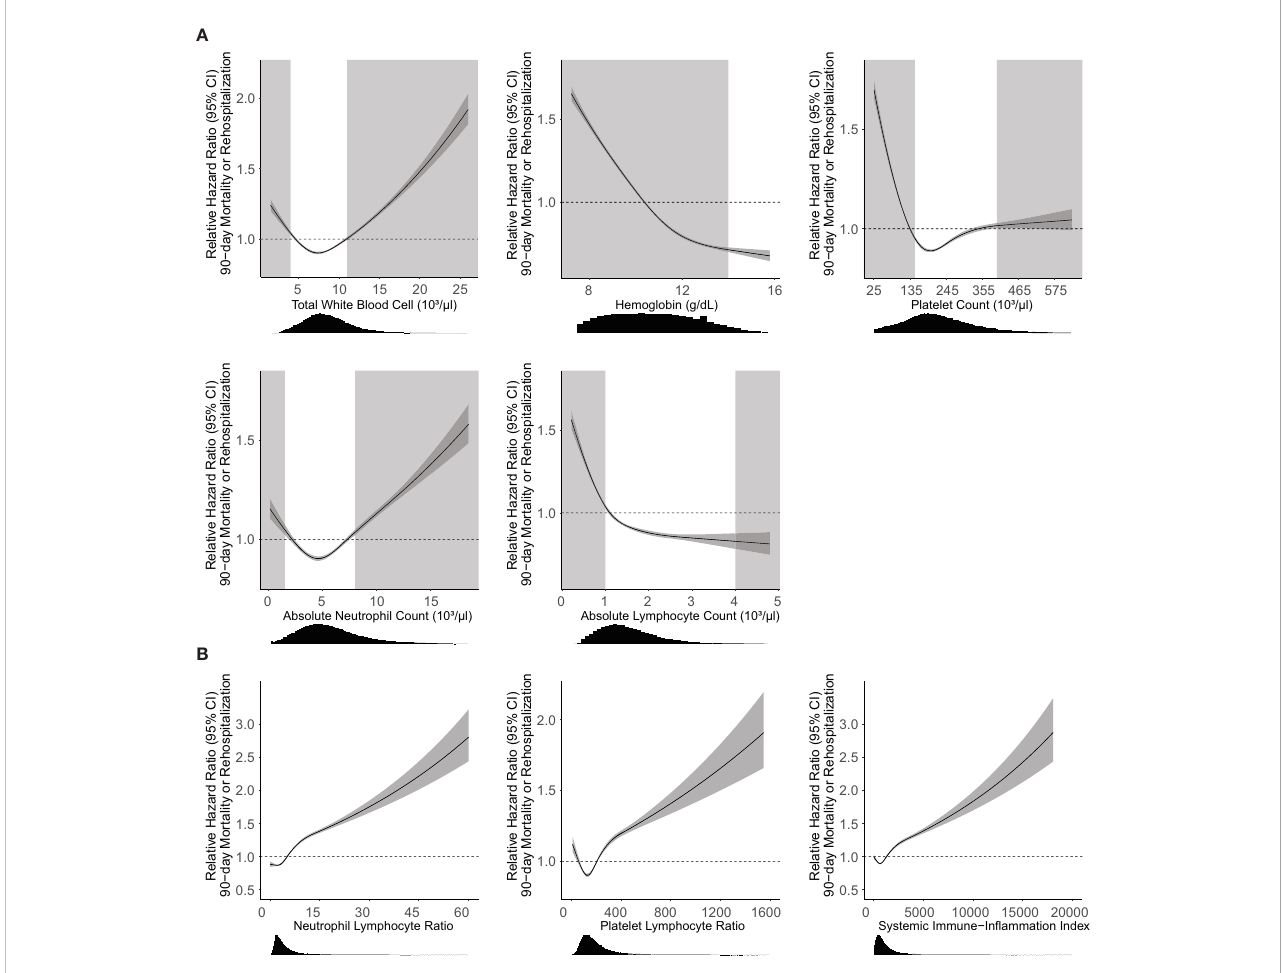
FIGURE 2 Association of CBCD parameters with 90-day mortality or rehospitalization. Unadjusted Cox proportional hazard regression (95% CI, dark gray) with relative hazard ratio shown for individual (A) and combination (B) CBCD parameters. Histogram distributions of parameters shown below the x-axis. Light gray boxes indicate CBCD parameters outside of the normal clinical range for individual parameters. There are no well-established normal ranges for NLR, PLR, or SII for the general population. Neutrophil Lymphocyte Ratio = absolute neutrophil count/absolute lymphocyte count. Platelet Lymphocyte Ratio = platelet count/absolute lymphocyte count. Systemic Immune-In fl ammation index = (absolute neutrophil count x platelet count)/absolute lymphocyte